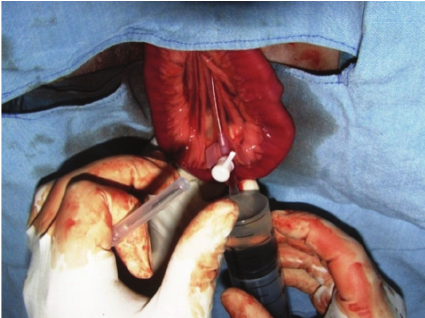
Figure 7: Laparotomy-assisted exteriorization of jejunal loop and catheterization of jejunal vein and rapid infusion of positive contrast agent (Urografin 76%) in 1-year-old male mixed-breed dog, suspected for portosystemic shunting.